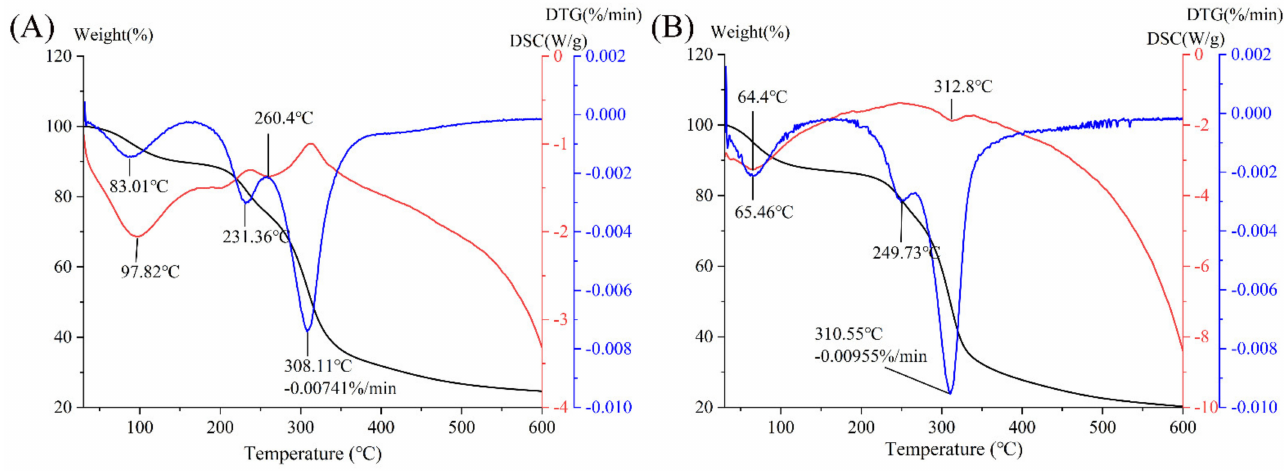
Figure 3. Thermal analysis of PPP ( A ) and PPP-Cr(III) ( B